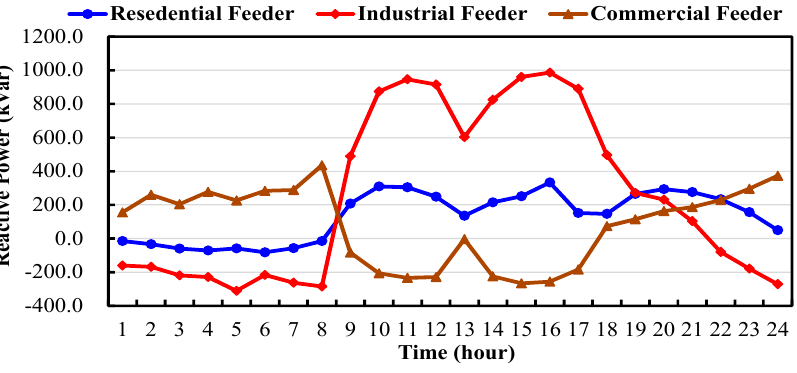
Figure 4. Active power curves of three test feeders.